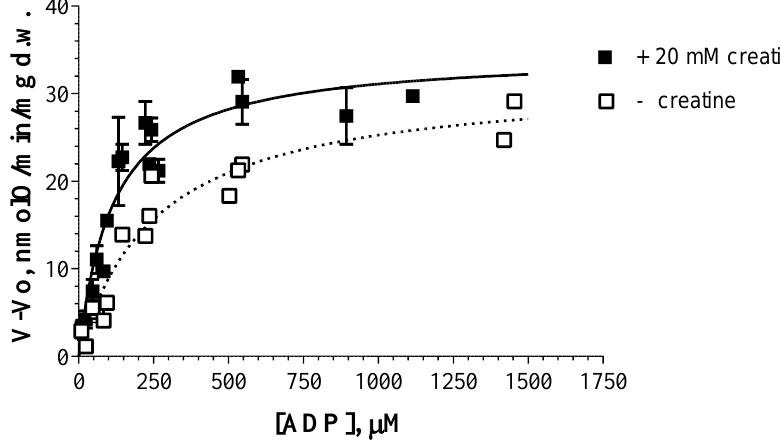
Figure10. ThedependenceoftherespirationratesofratcardiacfibersontheexternalADPconcentration: Figure 10. The dependence of the respiration rates of rat cardiac fibers on the external ADP the e ff ect of creatine. The substrate: octanoyl- dl -carnitine 0.36 mM + malate 0.24 mM. The data of five concentration: the effect of creatine. The substrate: octanoyl- DL -carnitine 0.36 mM + malate 0.24 mM. separate paired experiments are presented. V max values (in nmol O / min / mg dry weight) were found to The data of five separate paired experiments are presented. V max values (in nmol O/min/mg dry be similar: 29.9 ± 1.8 (the medium without creatine) and 31.1 ± 1.6 (the medium with 20 mM weight) were found to be similar: 29.9  1.8 (the medium without creatine) and 31.1  1.6 (the medium with 20 mM creatine).